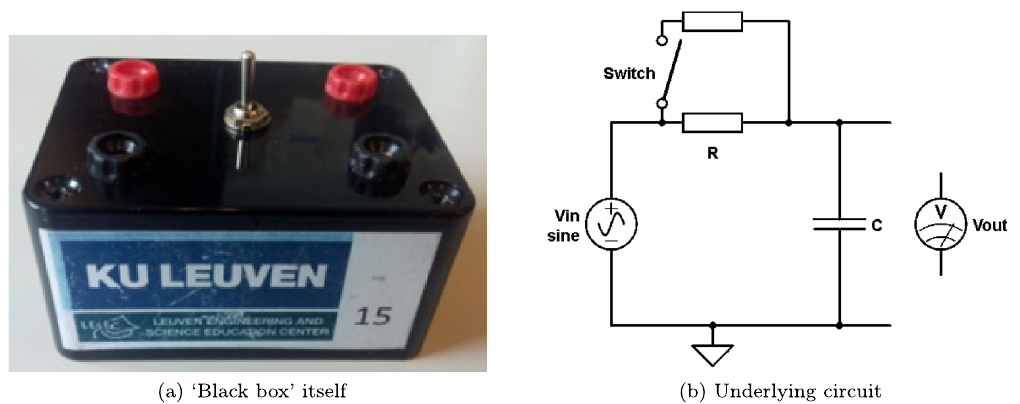
FIG. 5. Black box used in the new labs. (a) The box itself: The black connectors are the ground level, while the red ones are the signal. The input is on the left, output on the right. Every box is unique and has an individual number (here 15). An example of an underlying circuit is shown in